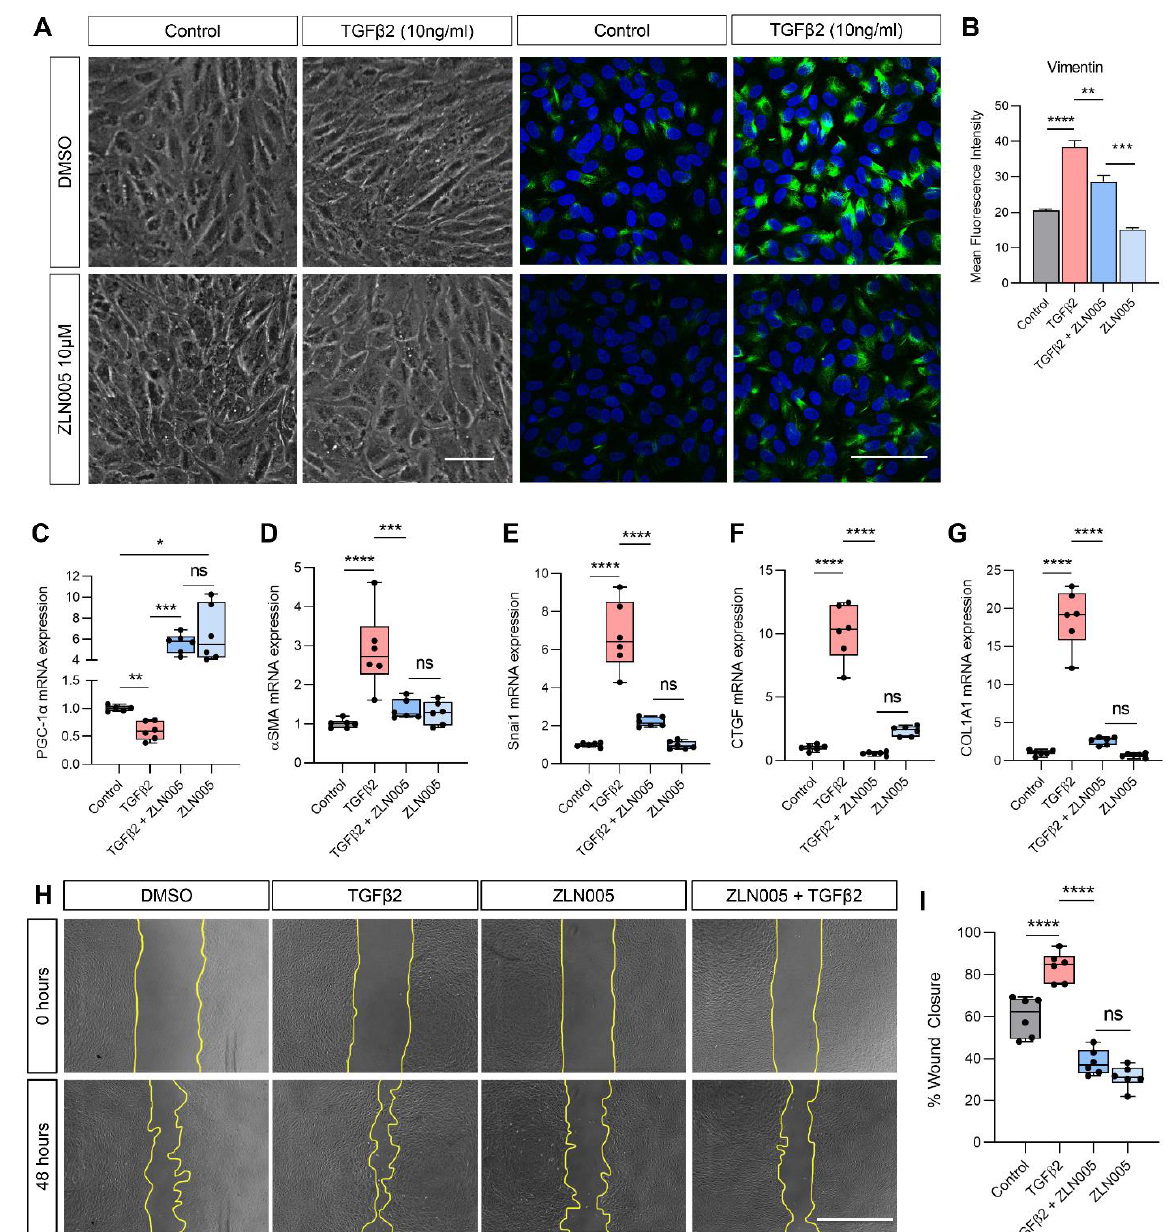
Figure 4. TGF β 2 suppresses PGC-1 α and ZLN005, the selective small molecular activator of PGC-1 α , blocks TGF β 2-induced EMT. ( A ) Representative phase-contrast microscopy and immunofluorescence for vimentin (green) with DAPI at 72 h with or without TGF β 2 and/or ZLN005 ( n = 3, scale bar is 50 µ m) and ( B ) quantification of mean fluorescence intensity. Quantification of ( C ) PGC-1 α and mesenchymal genes ( D ) α -SMA , ( E ) Snai1 , ( F ) CTGF and ( G ) COL1A1 by qPCR at 24 h with or without TGF β 2 and/or ZLN005 treatment ( n = 6). ( H ) Representative phase-contrast microscopy images for the scratch wound migration assay at 48 h with or without TGF β 2 and/or ZLN005 ( n = 6, scale bar is 100 µ m) and ( I ) quantification of percentage wound closure ( n = 6). Significance was determined by one-way ANOVA with Tukey’s or Dunnet’s T3 post-hoc analysis. Error bars are means ± SEM. * p ≤ 0.05; ** p ≤ 0.01; *** p ≤ 0.001; **** p ≤ 0.0001; ns, not significant.